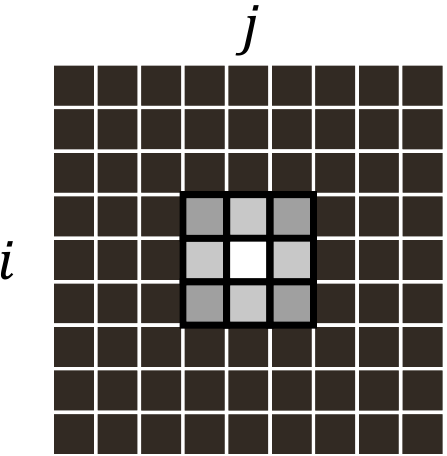
Figure 8. The frequency-away